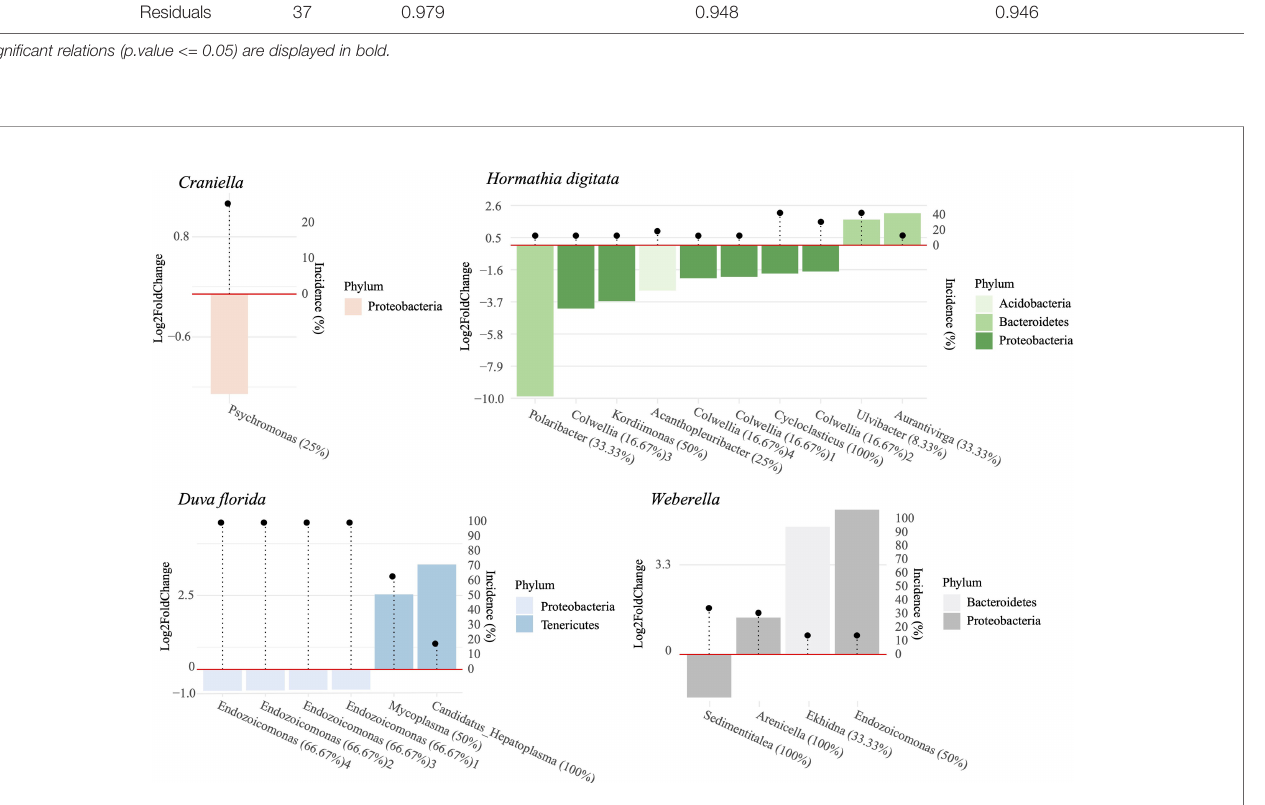
FIGURE 8 | Log2 fold change in relative abundance of bacterial ASV per species signi fi cantly associated with distance from the cage. Bacterial taxa with positive log2 fold change values were more abundant at the reference sites and vice-versa. Incidence of each bacterial taxa is indicated by the black dots. Percentages following bacterial genera names indicate the percent of ASVs within that genus that responded to a distance gradient from the fi sh farm.